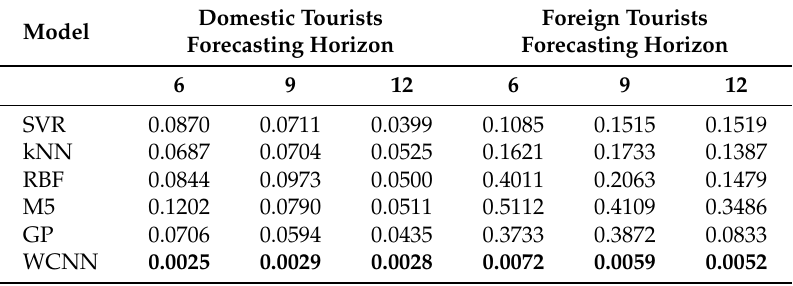
Table 2. Performance comparison based on RMSE of WCNN against the state-of-the-art machine learning regression